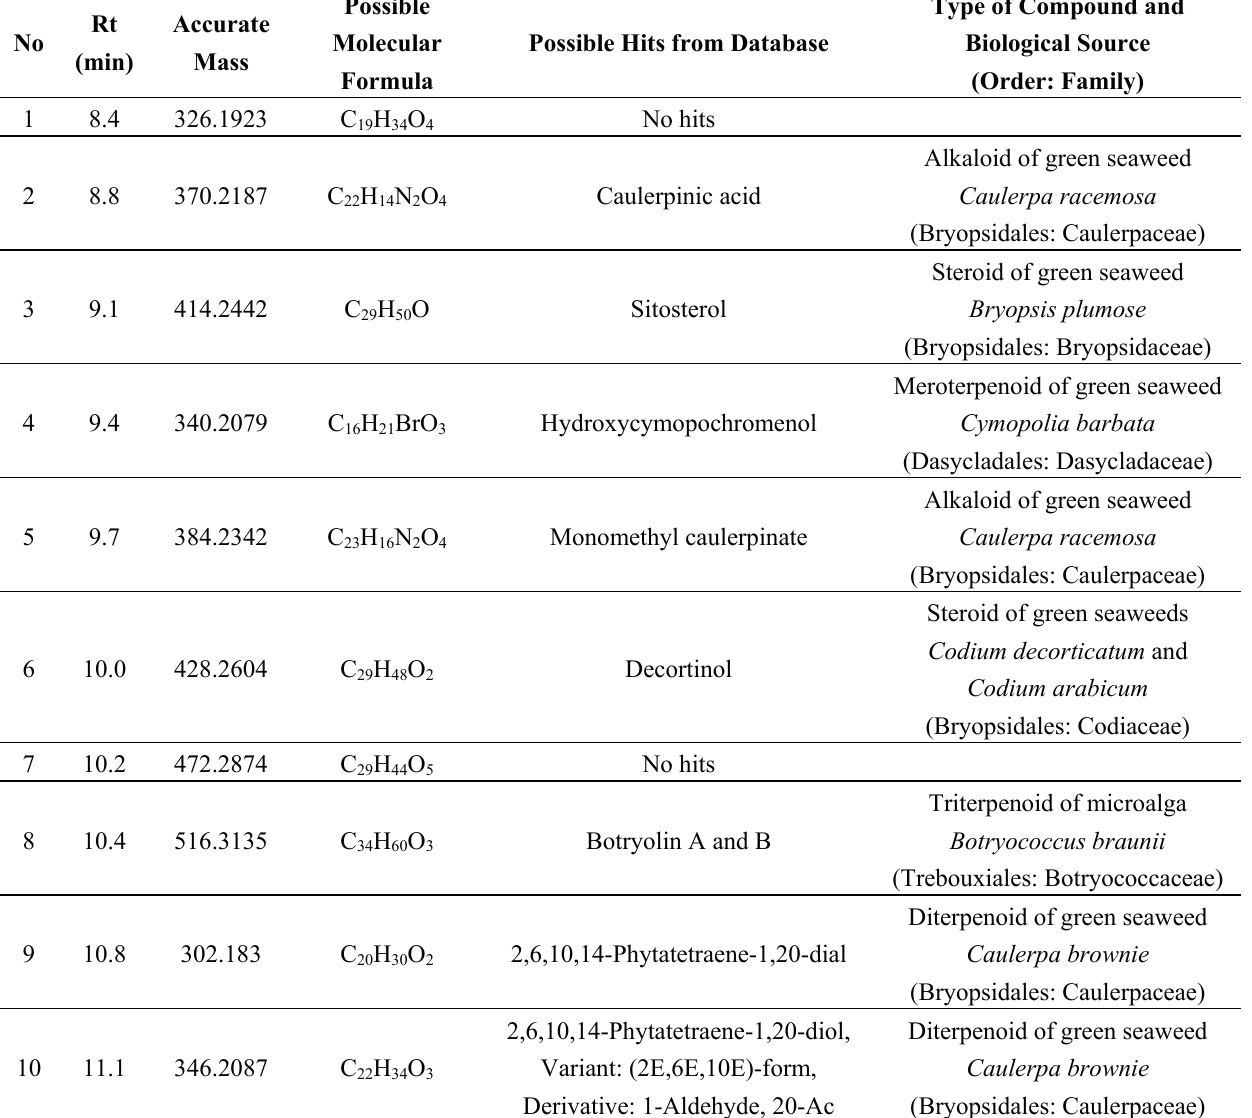
Table 7. LC-MS analysis and database search of main peaks in chloroform extract of Bryopsis pennata (Bryopsidales: